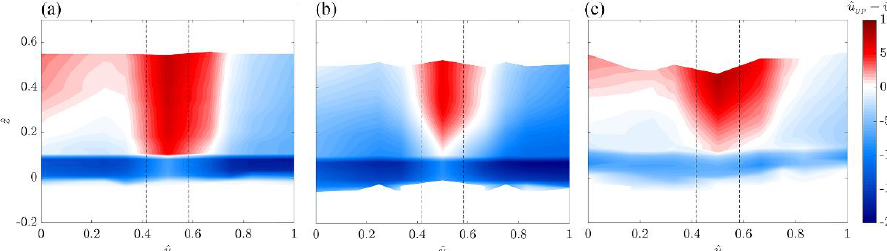
Figure 5. Contours of the dimensionless time-averaged accelerated (𝑢̂ 𝑈𝑃 −𝑢̂) < 0 and decelerated (𝑢̂ 𝑈𝑃 −𝑢̂) > 0 flow field in the upstream plane section (from LE to RE) for ( a ) Run 1, ( b ) Run 2 and ( c ) Run 3. The black dashed lines show the cylinder position.